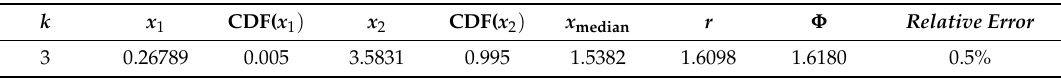
Table 2. Values of x 1 , x 2 , x median , the ratio r , and the relative error with respect to Φ ( k =